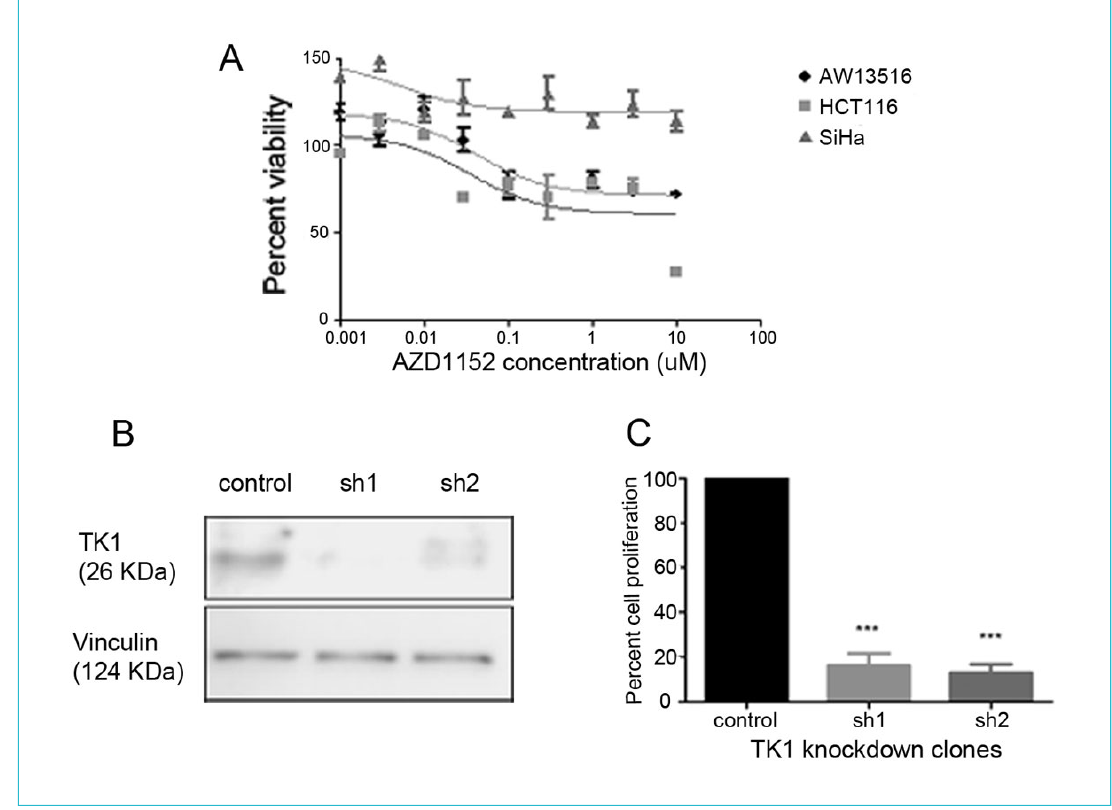
Figure 4: AURKB and TK1 show oncogenic dependency in AW13516 cells. ( A) MTT assay with AZD1152-HQPA inhibitor in AW13156, HCT116 and SiHa cells. (B) Knockdown confirmation of TK1 in AW13516 cells by western blotting. (C) Cell proliferation assay in control and TK1 knockdown clones of AW13516